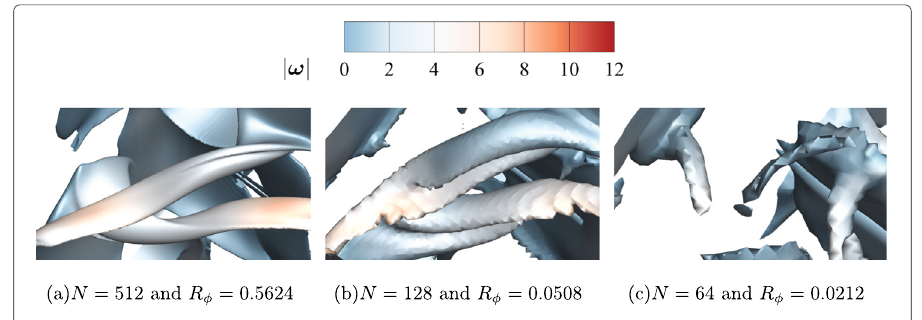
Fig. 7 Comparison of isosurfaces of numerical VSF solutions in the closed-up view in the TG flow at t TG = 7.0 for Re = 400 with different N and R